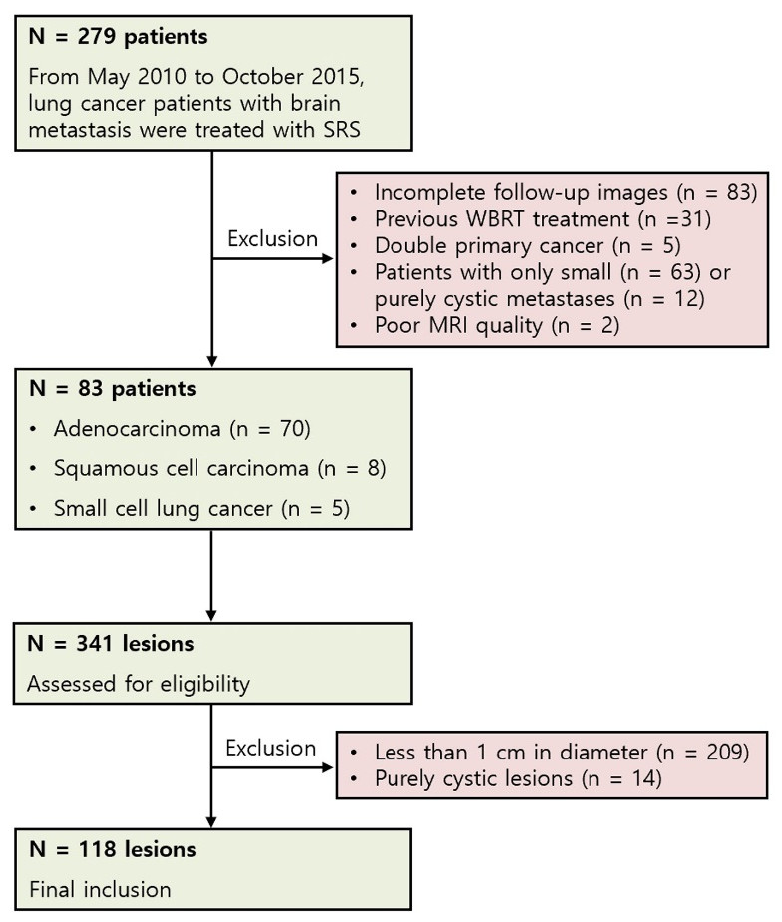
Figure 1. Patient and lesion selection flowchart (SRS, streotactic radiosurgery; WBRT, whole-brain radiotherapy; MRI, magnetic resonance imaging).